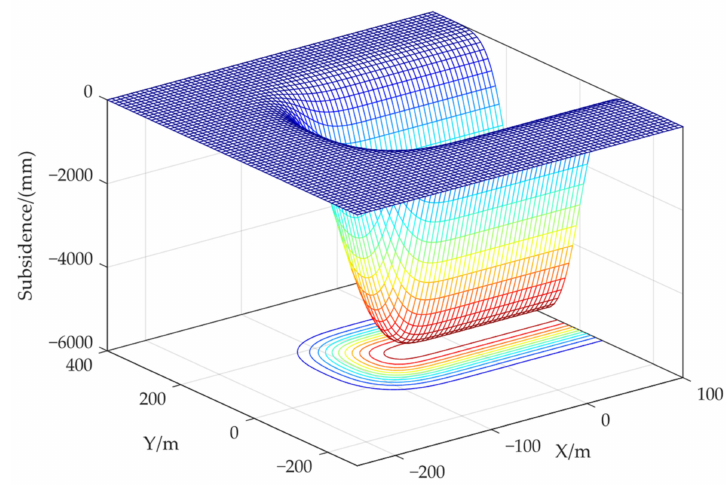
Figure 12. Subsidence basin based on PIM (Side of open-off cut).